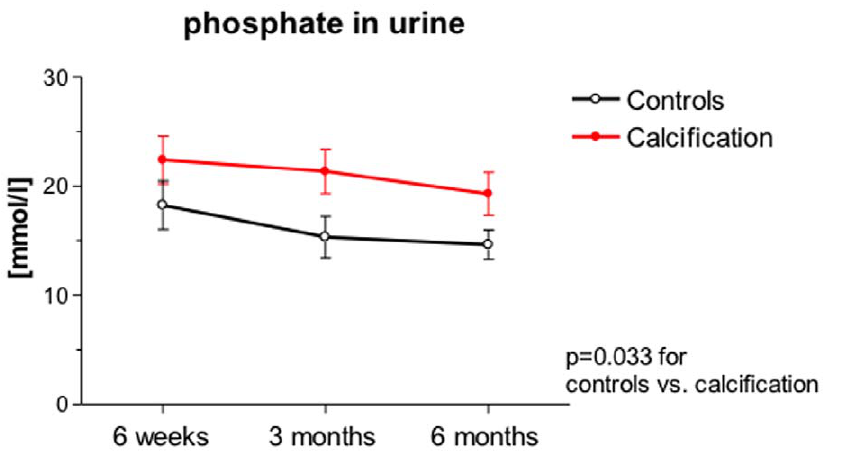
Figure 5. Urinary phosphate levels in NC patients in comparison to control transplant patients without signs of calcification at the indicated time points are shown. Patients with calcification are depicted in red.